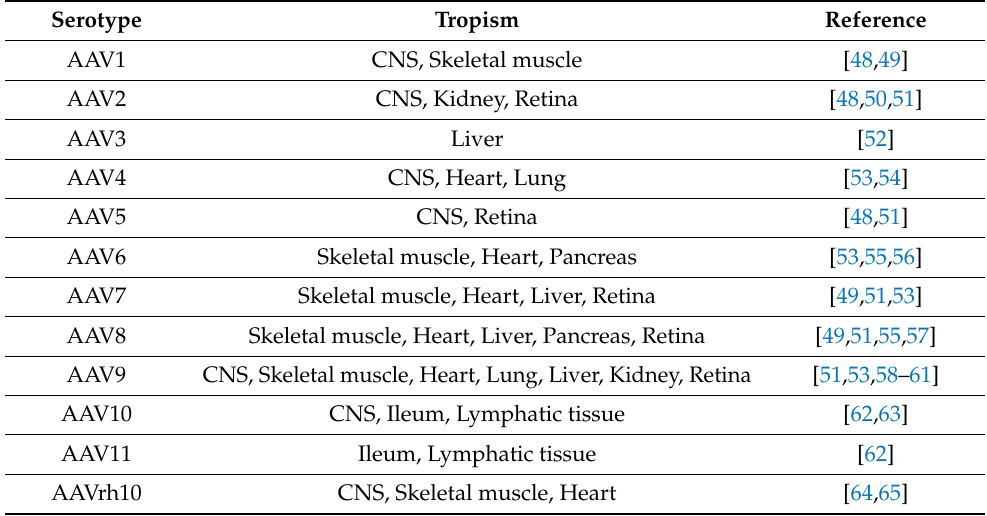
Table 2. Tropism of naturally occurring AAVs.